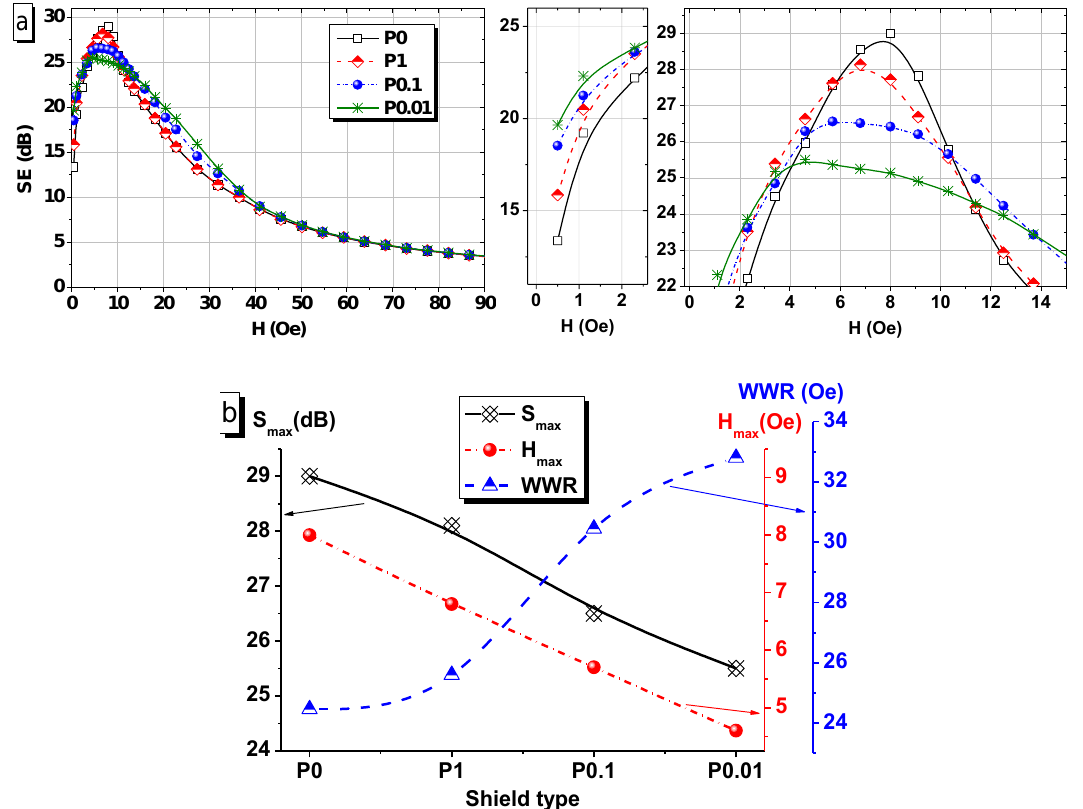
Figure 7. SE of FeNi shields: ( a ) dependence of SE on the strength of the applied magnetic field in the range from 0 to 90 Oe, ( b ) the maximum value of the shielding efficiency (SE max —black), the strength of the magnetic field that corresponds to SE max (H max —red) and the width of the shield’s working range (WWR—blue).